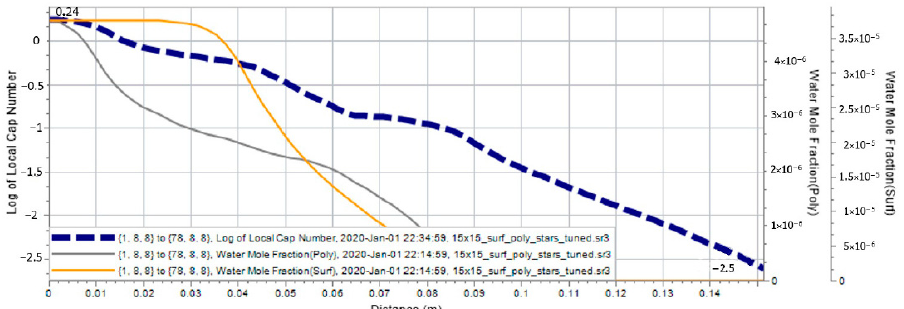
Figure 19. Change in the capillary number logarithm along the model at the moment of reaching maximum value.